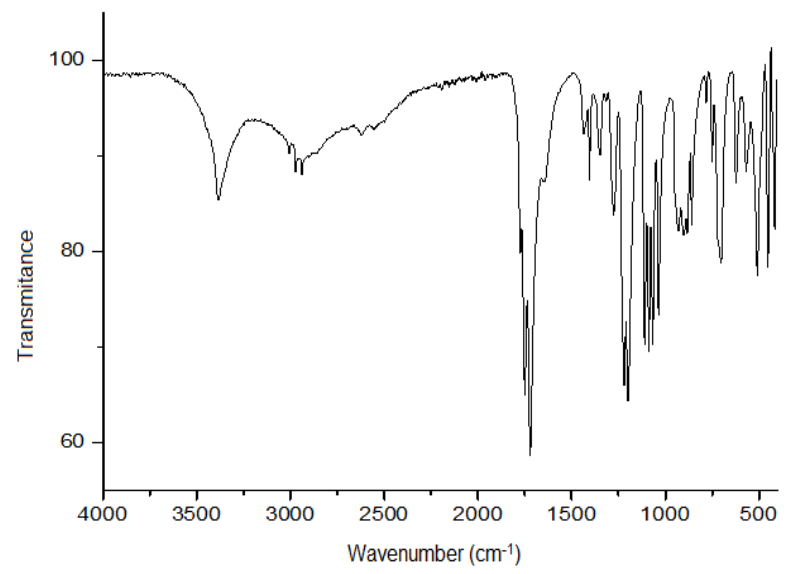
Figure 2. Infrared spectrum of purified crystals obtained from Hibiscus sabdariffa calyces acetonic extract.